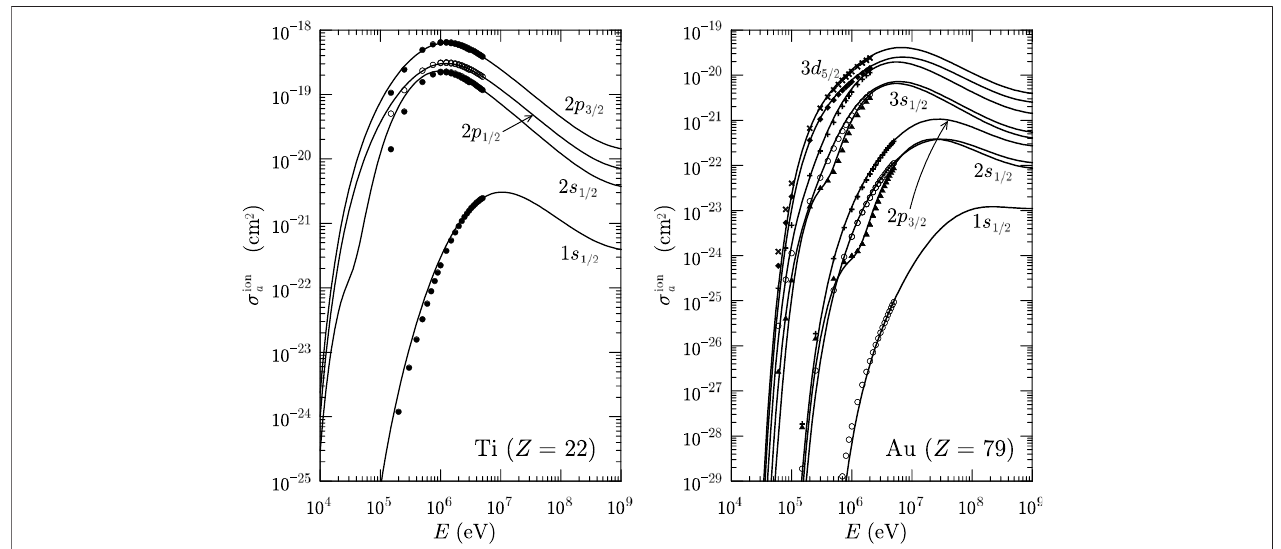
FIGURE 1 | Cross sections for ionization of the K, L and M subshells of titanium and gold by impact of protons as functions of the kinetic energy of the projectile. Solidcurvesrepresent thevaluesinthe PENH database.Symbolsareresultsfrom equivalentPWBA calculationsbyChenand Crasemann [21,22],whichalsoincludethe binding and Coulomb-de fl ection